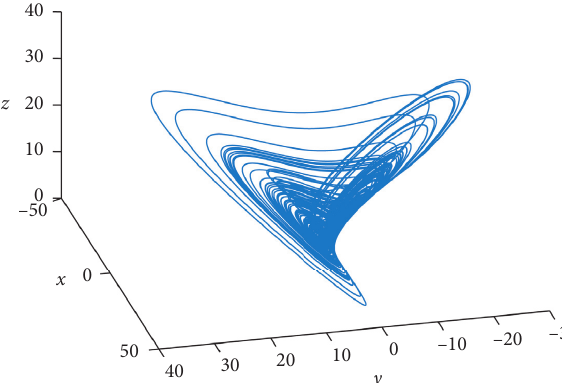
Figure 5: Dynamics of Lu et al.’s fractional-order system with the order α � 0 . 95, in context of x , y , and z directions.